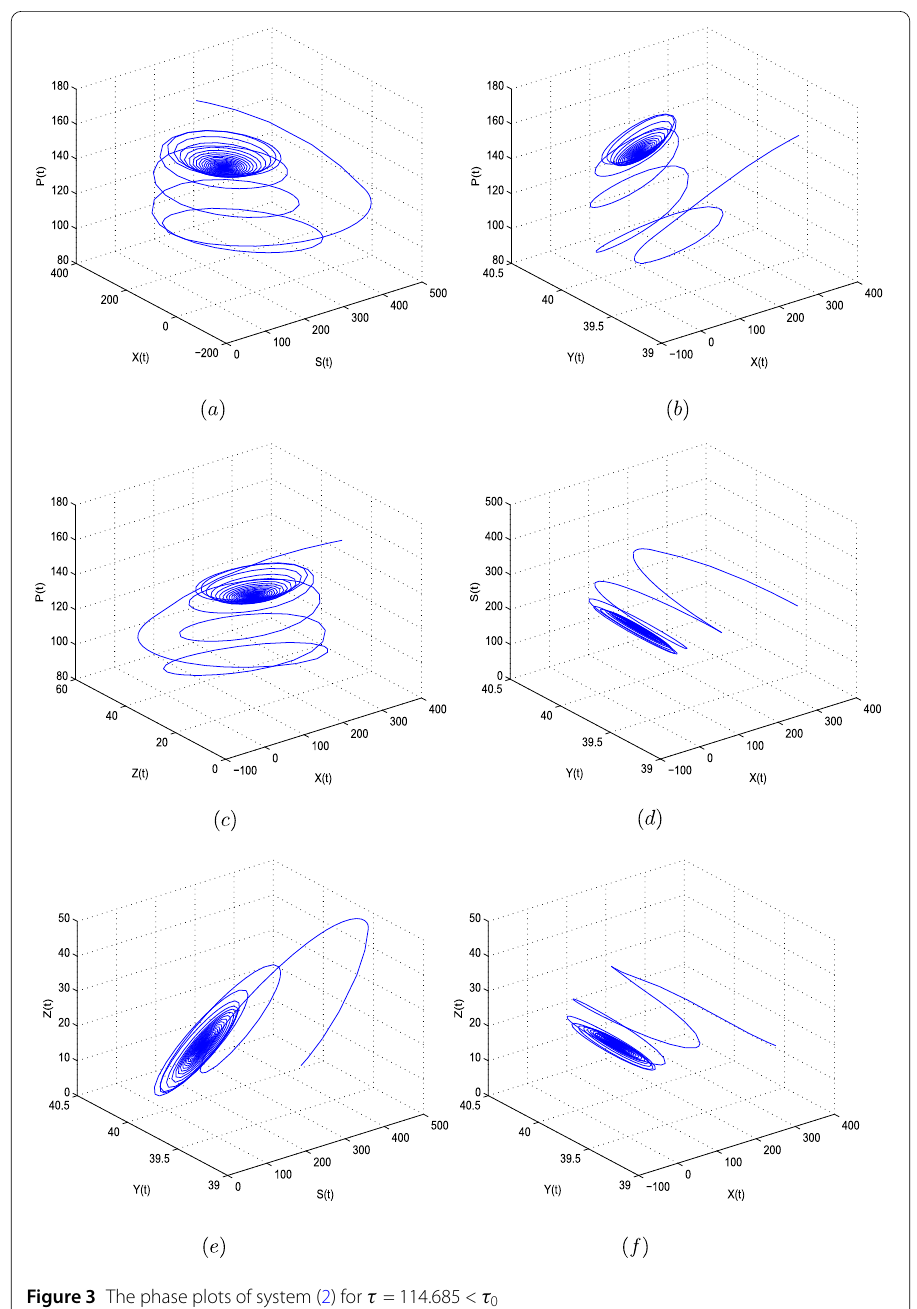
Figure 3 The phase plots of system (2) for τ = 114.685 < τ